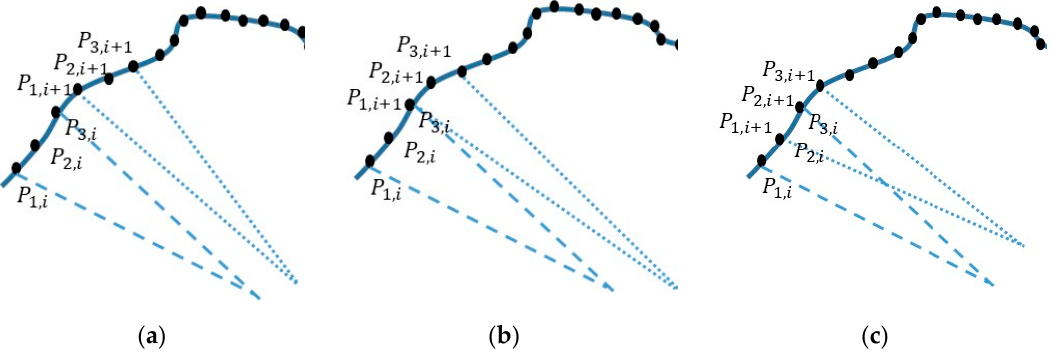
Figure 4. Sampling patterns: measurement of roundness with total of M number of sampled points. ( a ) Non-overlapping arc-segmentations, i.e., M = 3N . ( b ) Overlapping arc-segmentations with one common point, i.e., M = 2N + 1 . ( c ) Overlapping arc-segmentations with two common points, i.e., M = N – 2 . Any two segments should not share same three points to avoid redundancy.